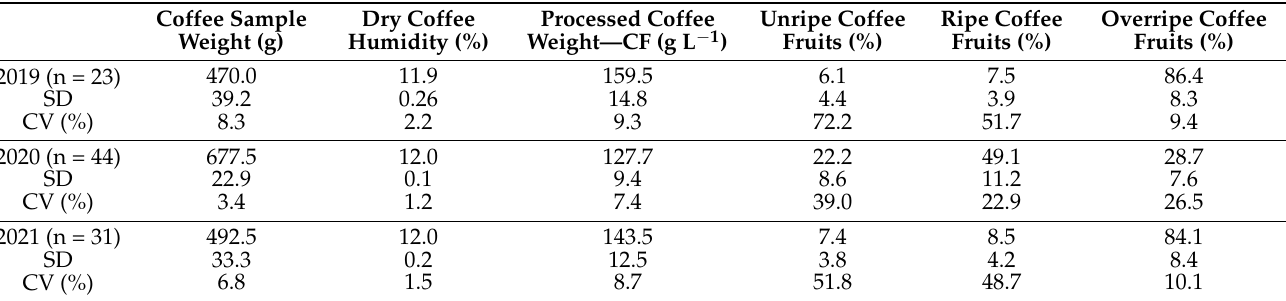
Table 1. Coffee fruit weight, maturity stage, and CF from samples collected over three consecutive harvests (2019 to